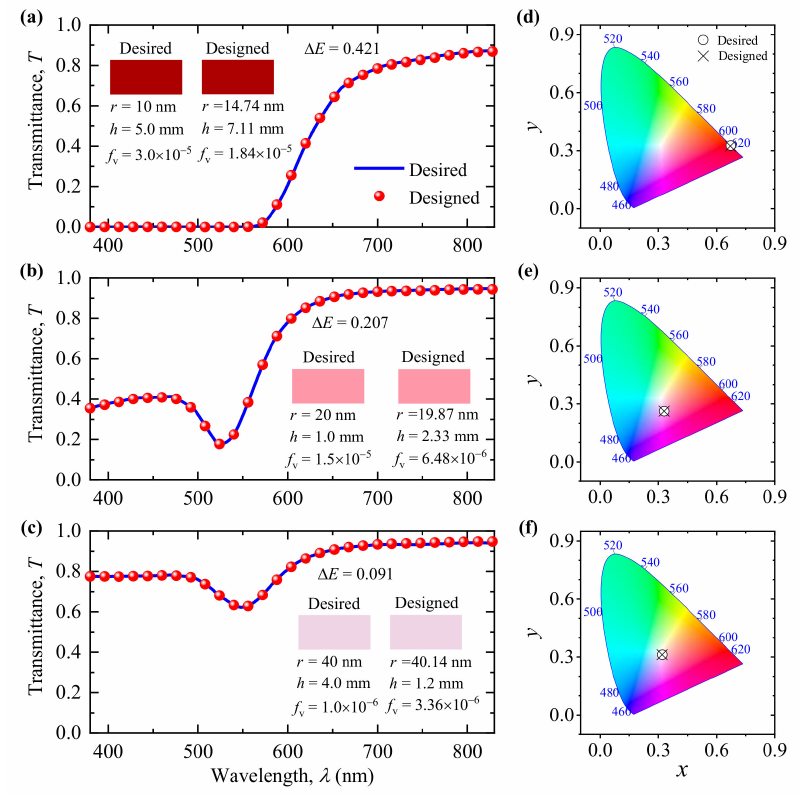
Figure 8. Inversely designing the geometric parameters of gold nanoparticle systems for desired colors. ( a – c ) The transmittance spectra of the desired (lines) and designed (points) colors. ( d – f ) The corresponding CIE chromaticity coordinates of the desired (circles) and designed (crosses) colors. The geometric parameters for both desired and designed colors and the corresponding color differences are inserted in ( a – c ). The color property parameters are as follows: ( a ) Desired color: L = 34.09, a = 63.99, b = 58.25; designed color: L = 34.49, a = 64.04, b = 58.37. ( b ) Desired color: L = 73.96, a = 40.44, b = 8.03; designed color: L = 73.88, a = 40.57, b = 8.17. ( c ) Desired color: L = 87.82, a = 11.78, b = − 4.79; designed color: L = 87.75, a = 11.81, b = −